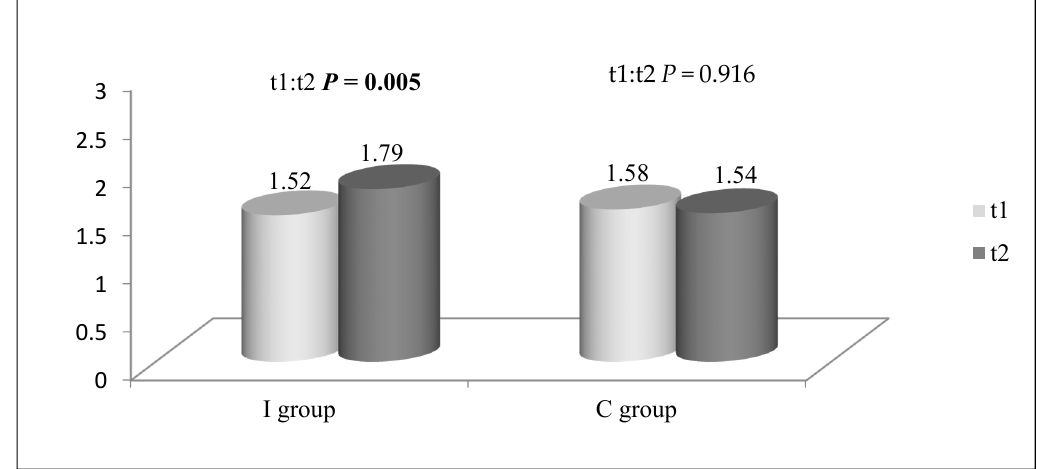
Figure 1. Average daily intake of dairy (servings) in the I group and the C group in t1 and t2 .